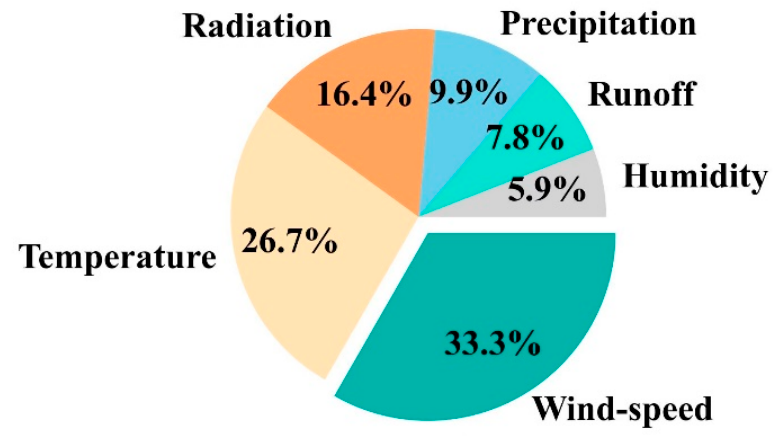
Figure 11. Importance of climate factors on evaporation based on RF in QHL.